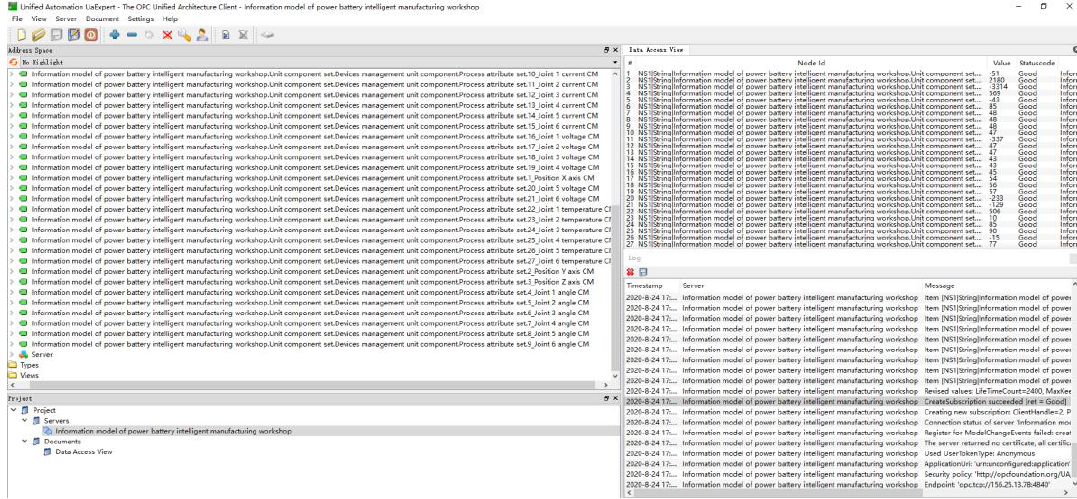
Figure 12. Data results of the OPC UA client search server information model.